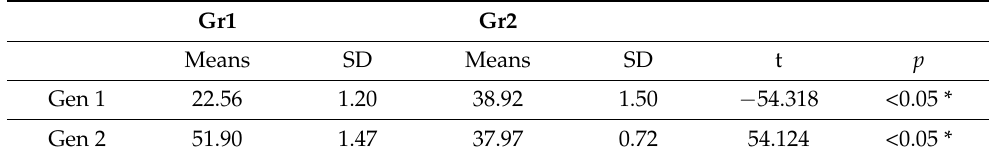
Table 3. Comparisons of the average generalization times by T TEST.